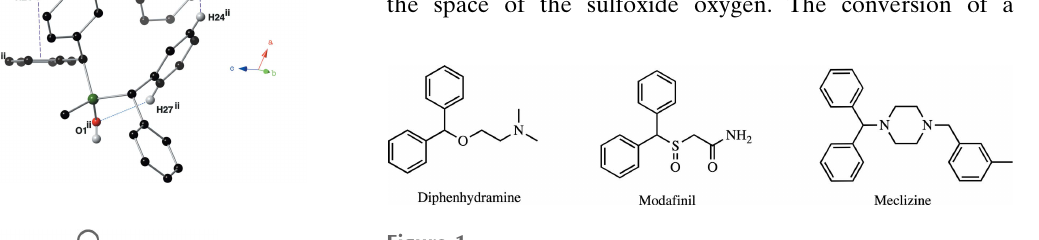
Figure 1 The benzhydryl group in some representative medicinal